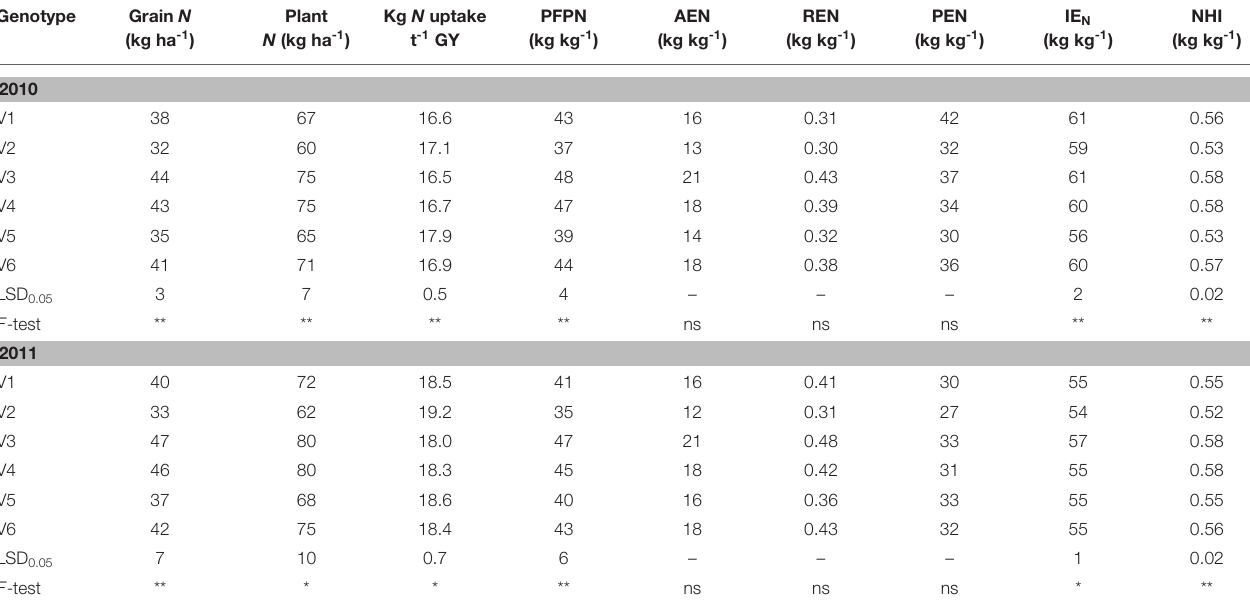
TABLE 5 | Nitrogen content and N use efficiencies among tested rice genotypes (average over N treatments). Genotype Grain N (kg ha -1